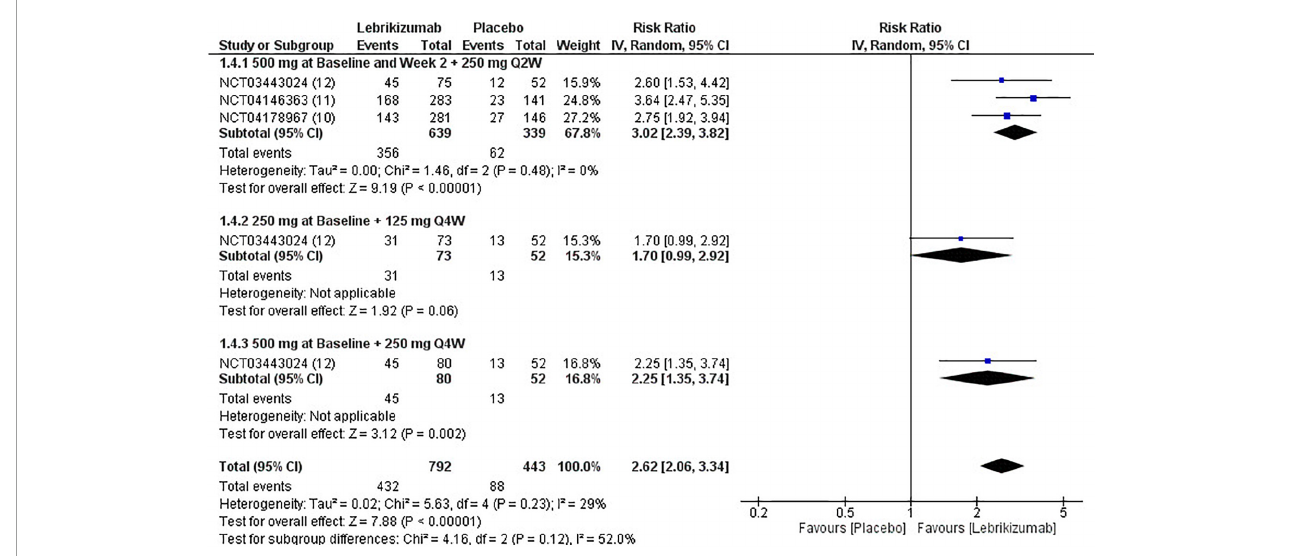
FIGURE8 Forest plot of EASI75 score. CI, confidence interval; IV, inverse variance; RR, risk ratio; Q2W, every 2 weeks; Q4W, every 4 weeks.